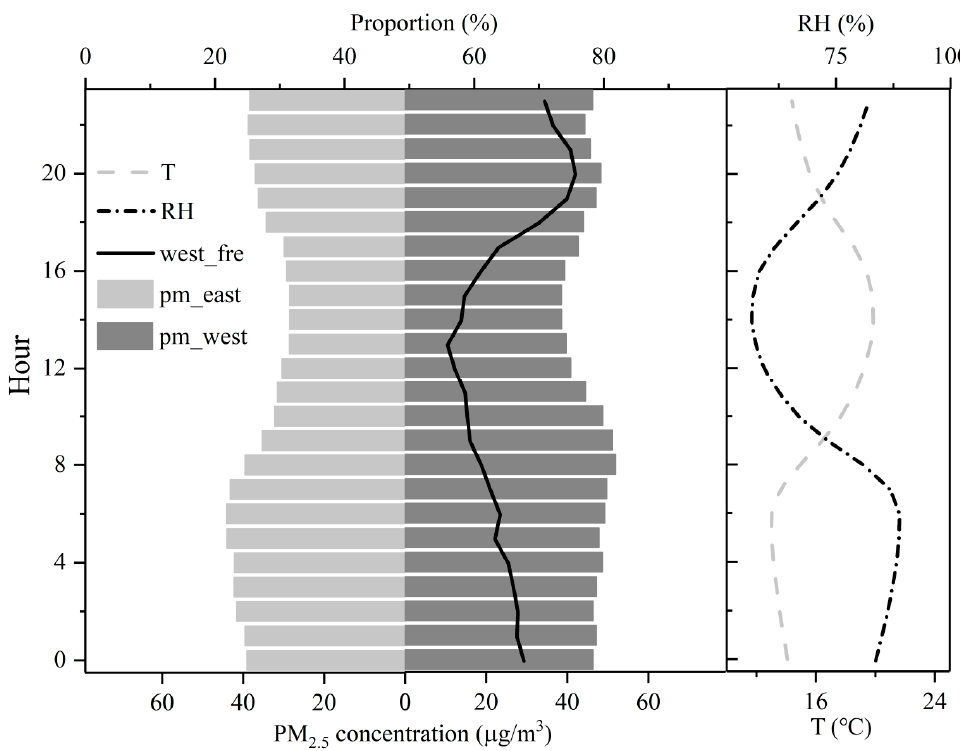
Figure 5. Hourly changes in PM 2.5 average concentration, easterly proportion, temperature and relative humidity under different wind directions in Yancheng. The dark gray and light gray bar charts, respectively, show the hourly average PM 2.5 concentration in Yancheng under easterly and westerly winds. The solid black line shows the proportion of easterly winds in Yancheng, the gray dashed line is the temperature, and the black dashed line is the relative humidity.